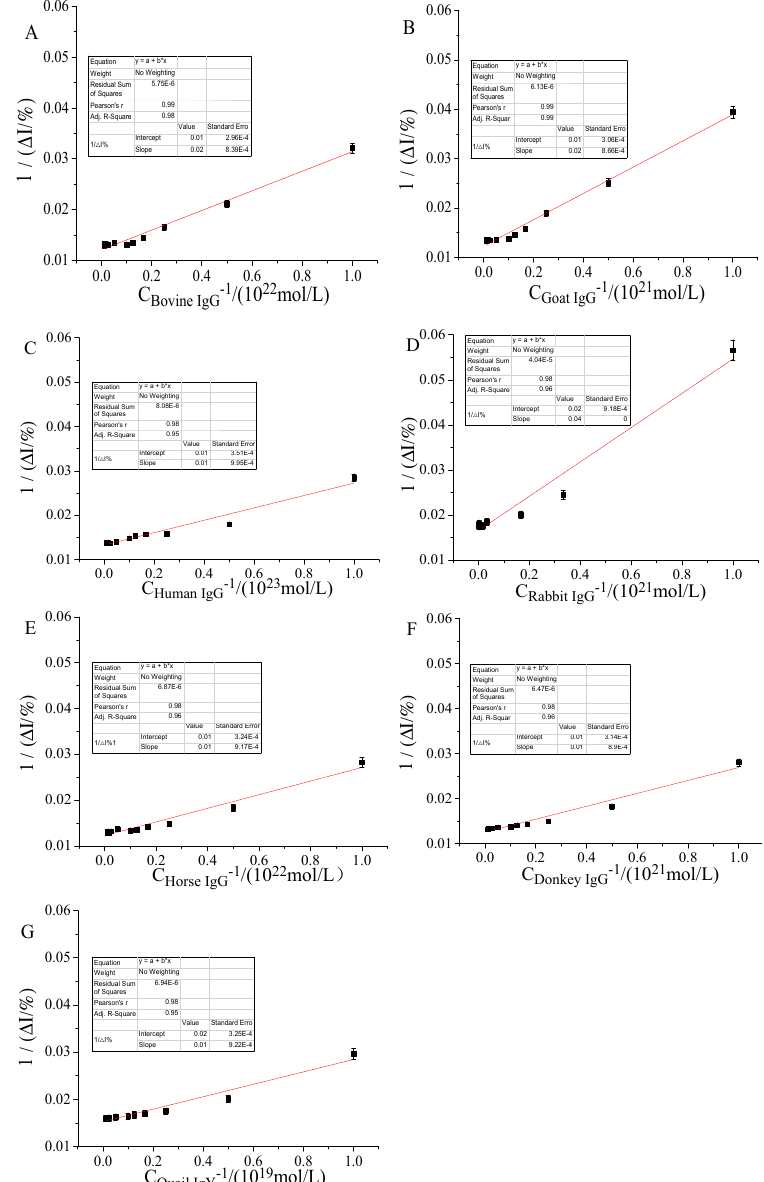
Figure 9. Double reciprocal curve of seven IgGs detected in a certain concentration range. ( A ) Bovine IgG 10 − 22 to 10 − 20 mol / L, ( B ) sheep IgG 10 − 21 to 10 − 19 mol / L, ( C ) human IgG 10 − 23 to 10 − 21 mol / L, ( D ) rabbit IgG 10 − 21 to 10 − 18 mol / L, ( E ) horse IgG 10 − 22 to 10 − 20 mol / L, ( F ) donkey IgG 10 − 21 to 10 − 19 mol / L, and ( G ) quail IgY 10 − 19 to 10 − 17 mol / L. Table 1. Linear regression equation, R 2 and K a of seven IgGs in a certain concentration range after interaction with hFc γ Rn.